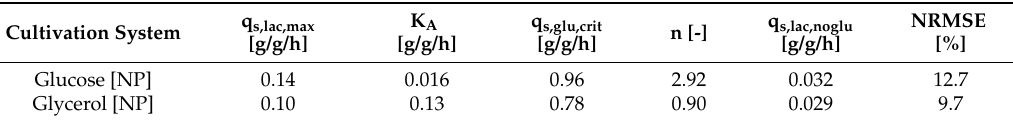
Table 3. Model parameters and normalized-root-mean-square-error (NRMSE) for the analysed cultivation without recombinant product production (NP).